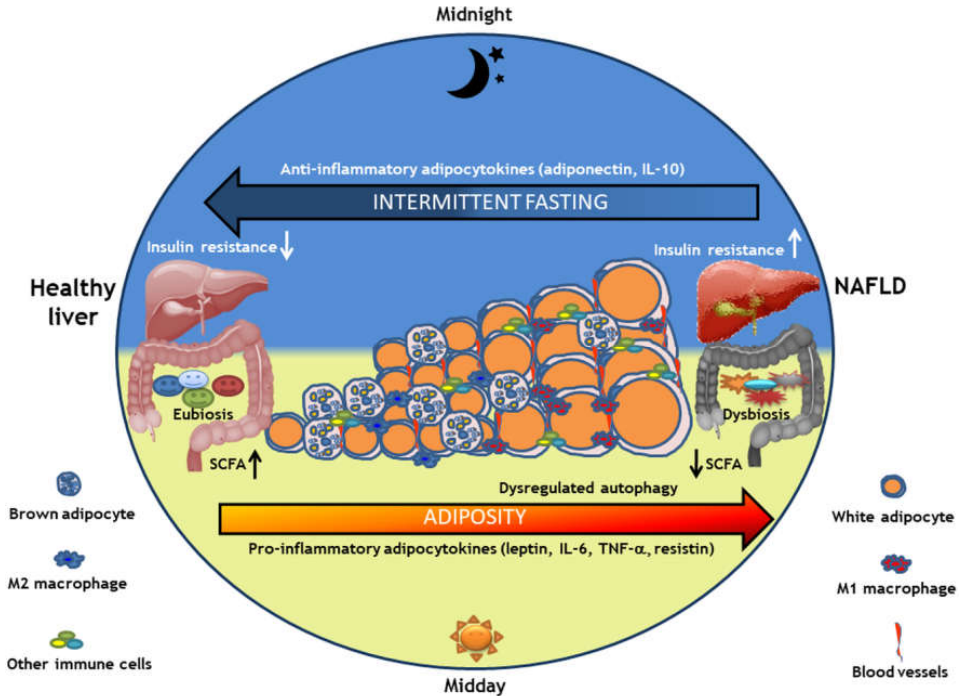
Figure 1. Potential mechanisms of action for effects of intermittent fasting in NAFLD. Obesity is a risk factor for NAFLD [3] and is associated with low-grade inflammation [2,32] marked by presence of increased white adipose tissue, increased pro-inflammatory M1 macrophages, decreased anti- inflammatory M2 macrophages [2], formation of new blood vessels (angiogenesis), increased gut microbial dysbiosis [40], and changes in autophagy-related physiological processes [41]. Intermit- tent fasting may play a role in circadian rhythm modulation [34,37], adipose tissue plasticity [35,36], adipokine production [23], and gut microbiome [23,33] through increased SCFA production [38,39] and autophagy [31], with potential to reverse inflammation, metabolic dysfunction, and impaired immune system regulation associated with NAFLD. Abbreviations: NAFLD, nonalcoholic fatty liver disease; SCFA, short-chain fatty acids.